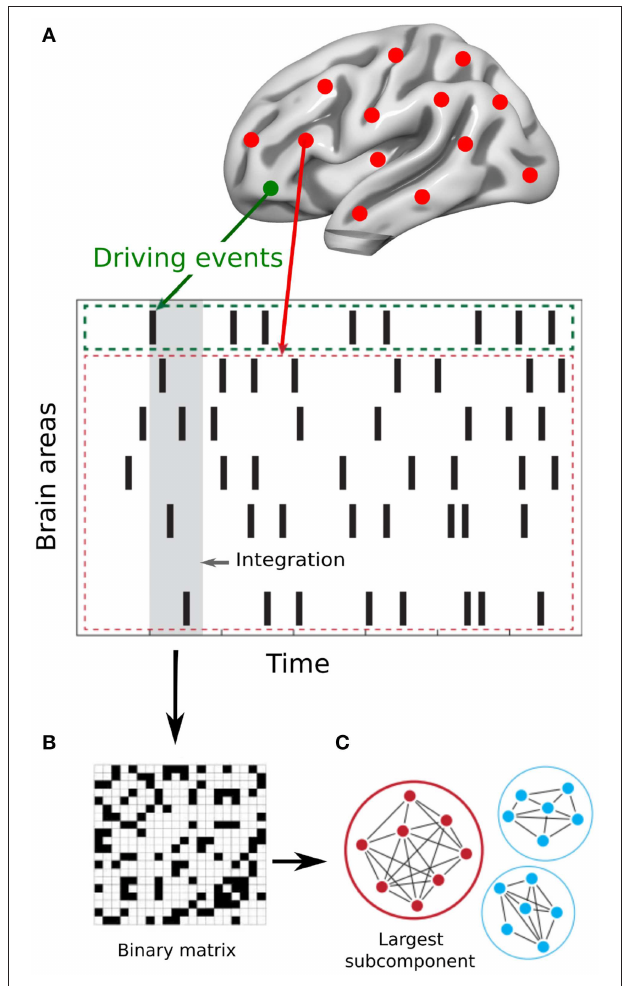
FIGURE 1 | Measuring intrinsic ignition. (A) Events were captured applying a threshold method Tagliazucchi et al. (2012) (see green area). For each event elicited (gray area), the activity in the rest of the network was measured in the time-window of 4TR (see red area). (B) A binarized matrix was obtained representing the synchronized events in each time window (i.e., when two brain areas have triggered an event) (C) Applying the global integration measure Deco et al. (2015), we obtained the largest subcomponent. By repeating the process for each driving event, we calculated the mean and the variability of the Intrinsic-Driven Integration for each brain area across the whole-brain network. Adapted from Deco and Kringelbach (2017).